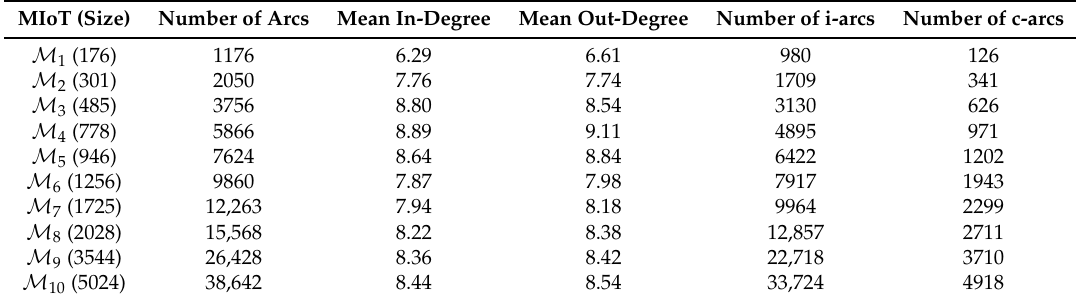
Table 1. Main features of the constructed